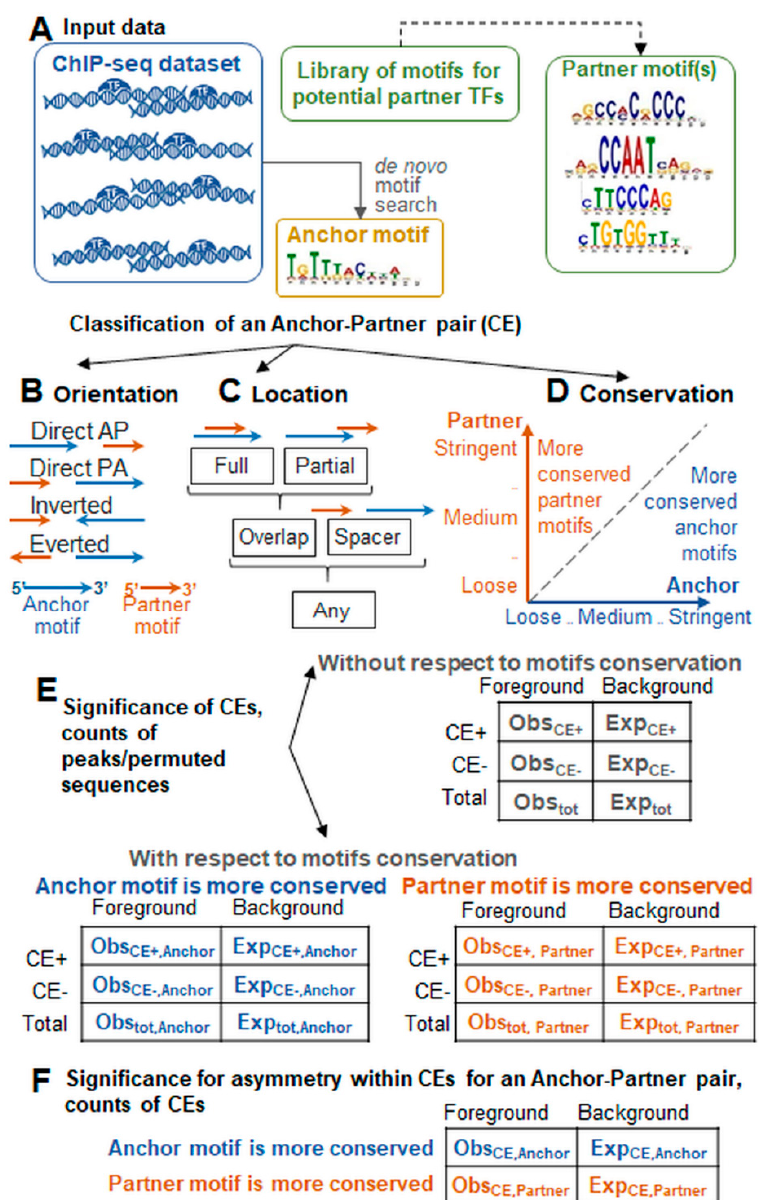
Figure 5. Web-MCOT workflow details. ( A ) Input data comprise a dataset of ChIP-seq peaks; a nucleotide frequency matrix for an Anchor motif; and a nucleotide frequency matrix for a Partner motif or designation of a public library of partner motifs. ( B – D ) show CEs classification according to orientations, locations (overlaps and spacers), and ratios of motifs conservation. ( E ) 2 × 2 contingency tables for computation of significances of enrichment for three CE types: without taking into account relationships of motifs conservation, and with an Anchor/Partner motif possessing higher conservation than Partner/Anchor motif (notations CE+/CE − respect sequences with/without CEs). ( F ) 2 × 2 contingency table for computation of significances of asymmetry within CEs.